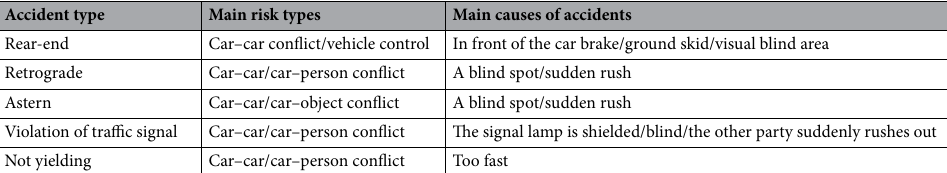
Table 4. The table reflects different types of accidents, main risks and main causes of accidents. The accident types are divided into back-end, retrograde, etc., the main risk types are vehicle conflict and vehicle control, etc., and the main causes of accidents are ground anti-skid, blind spots,